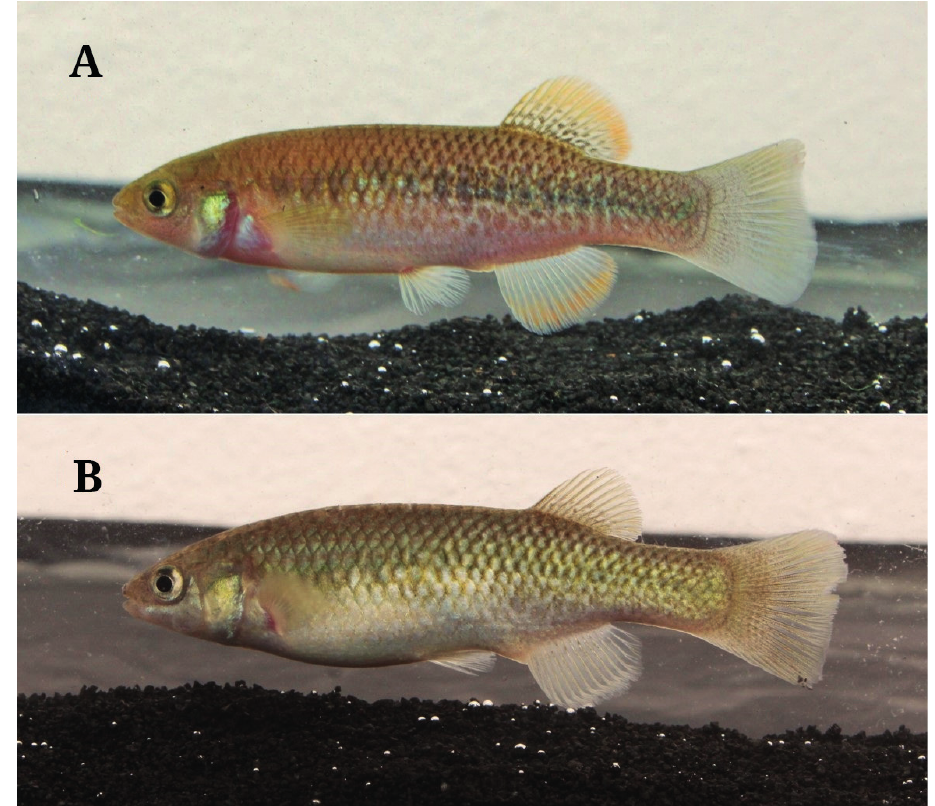
FIGURE 6 | Tlaloc candalarius . A. Male (MZ-UNICACH 7567, 71.4 mm SL); B. Female (MZ-UNICACH 7567, 78.8 mm SL); note the orange coloration of the dorsal and anal fins in the male.